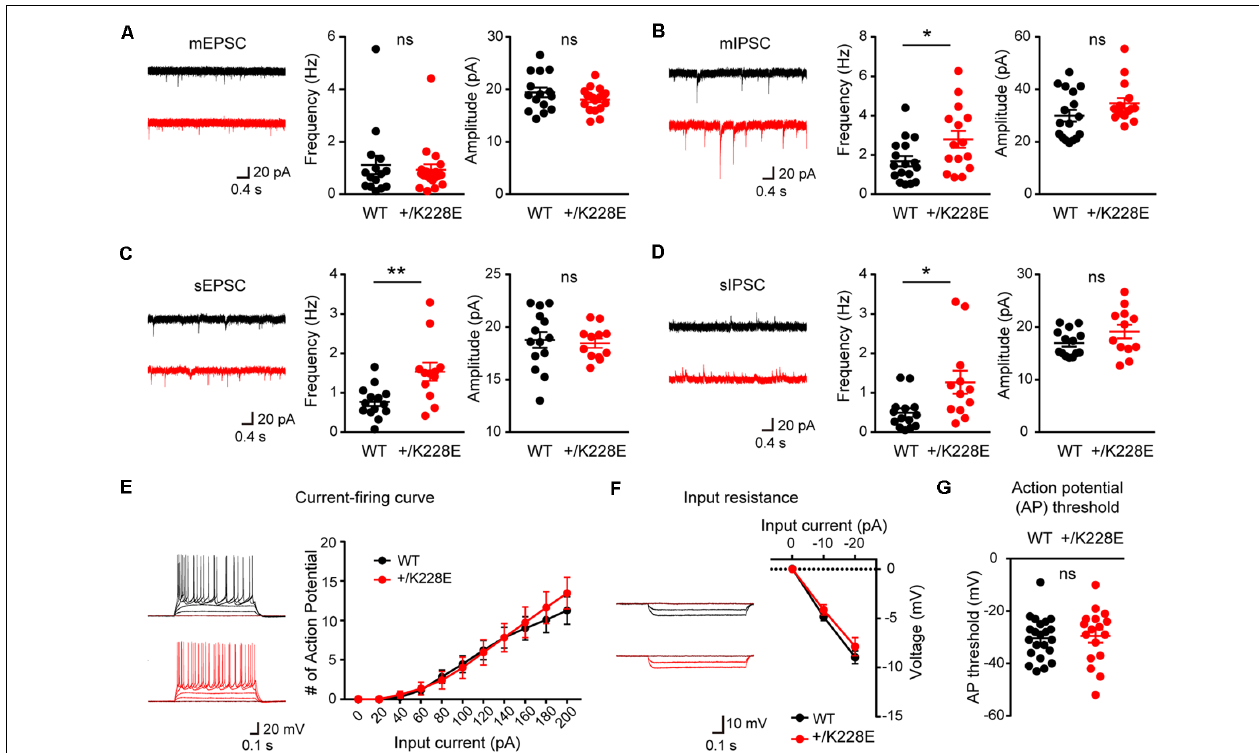
FIGURE 6 | Increased inhibitory synaptic transmission in cortical layer 6 pyramidal neurons. (A) Normal miniature excitatory postsynaptic current (mEPSC) frequency and amplitude in layer 6 pyramidal neurons in the prelimbic region of the mPFC of Tbr1 + / K228E (HT) mice (11–12 weeks). n = 15 neurons from three mice for WT and 19 neurons from four mice for HT, ns: not significant, Student’s t -test (mEPSC amplitude), Mann–Whitney test (mEPSC frequency). (B) Increased frequency but normal amplitude of miniature inhibitory postsynaptic currents (mIPSCs) in layer 6 pyramidal neurons in the prelimbic region of the mPFC of Tbr1 + / K228E (HT) mice (11–12 weeks). n = 17 neurons from three mice for WT and 15 neurons from three mice for HT, ∗ P < 0.05, ns: not significant, Mann–Whitney test (mIPSC amplitude), Student’s t -test (mIPSC frequency). (C) Increased frequency but normal amplitude of spontaneous EPSCs (sEPSCs) in layer 6 pyramidal neurons in the prelimbic region of the mPFC of Tbr1 + / K228E (HT) mice (11–12 weeks). n = 14 neurons from three mice for WT and 12 neurons from three mice for HT, ∗∗ P < 0.01, ns: not significant, Mann–Whitney test (sEPSC frequency), Student t -test (sEPSC amplitude). (D) Increased frequency but normal amplitude of spontaneous IPSCs (sIPSCs) in layer 6 pyramidal neurons in the prelimbic region of the mPFC of Tbr1 + / K228E (HT) mice (11–12 weeks). n = 14 neurons from three mice for WT and 12 neurons from three mice for HT, ∗ P < 0.05, ns: not significant, Mann–Whitney test (sIPSC frequency and amplitude). (E–G) Normal excitability of layer 6 pyramidal neurons in the prelimbic region of the mPFC in Tbr1 + / K228E (HT) mice (11–12 weeks), as indicated by current-firing curve (E) , input resistance (F) , and action potential (AP) threshold (G) . n = 22 neurons from four mice for WT and 17 neurons from four mice for HT, ns: not significant, current-firing curve: two-way repeated-measures ANOVA with Sidak’s multiple comparisons test, AP threshold: student’s t -test, input resistance: two-way repeated measures ANOVA with Sidak’s multiple comparisons